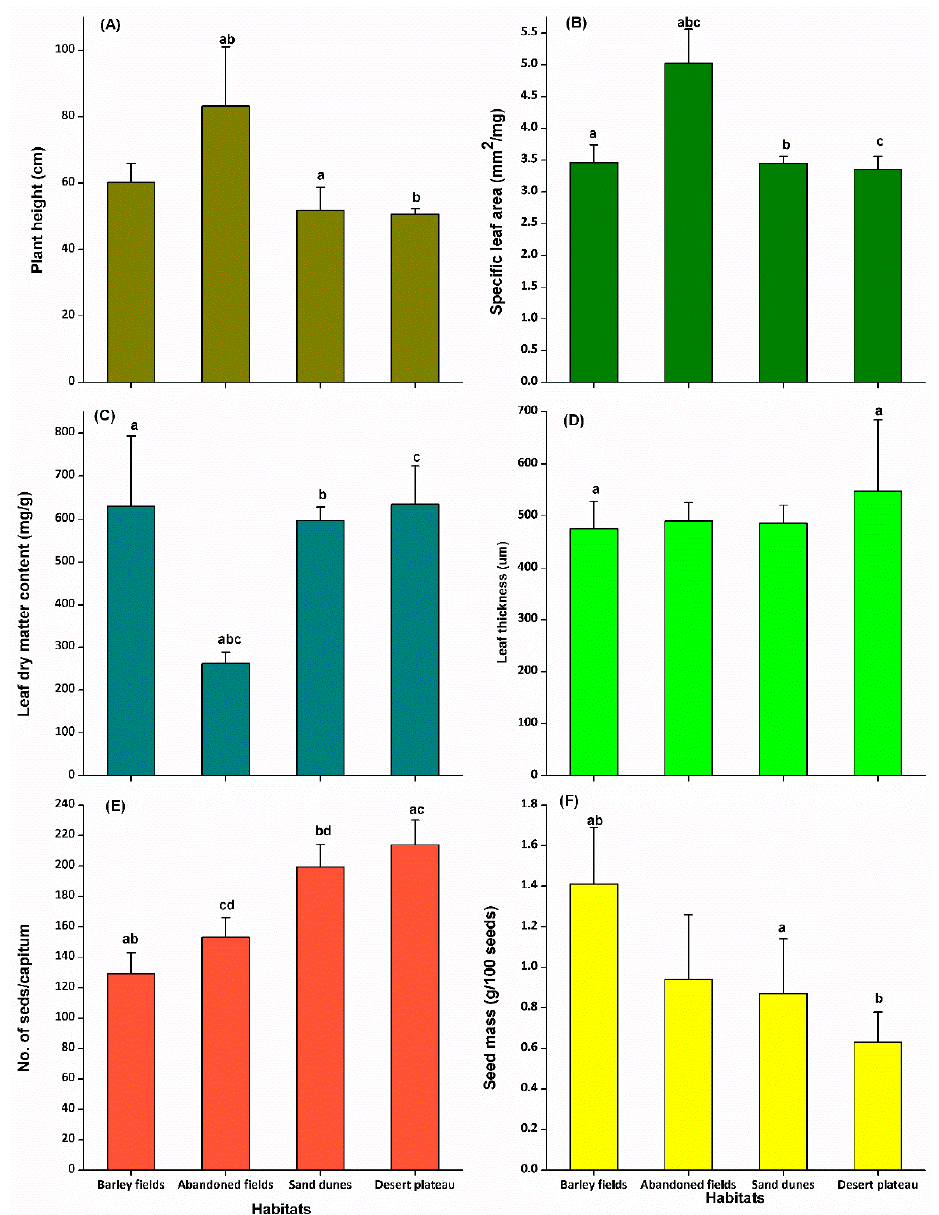
Figure 2. Comparisons of functional traits of Onopordum alexandrinum in anthropogenic and natural habitats. Bars with similar letters are significantly di ff erent according to Tukey’s studentized range test at the 0.05 probability level. ( A ): Plant height; ( B ): Specific leaf area; ( C ): Leaf dry matter content; ( D ): Leaf thickness; ( E ): Number of seeds; ( F ): Seed